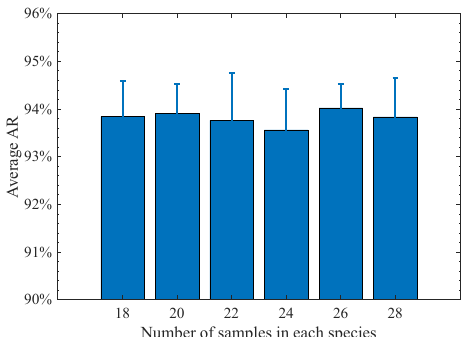
Figure 8. The average recognition AR of 11 species with respect to increasing numbers of sample in each species. Error bar is the standard deviation of the result under 10 independent realizations.